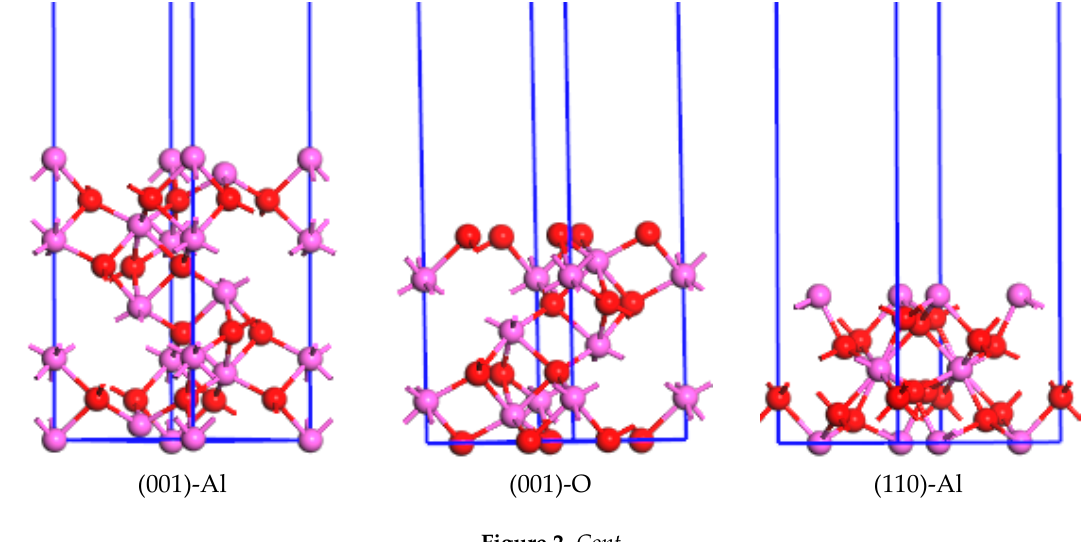
Figure 1. The band structure ( a ); density of states (DOS) ( b ); and projected DOS ( c , d ) of Al 2 O 3 .